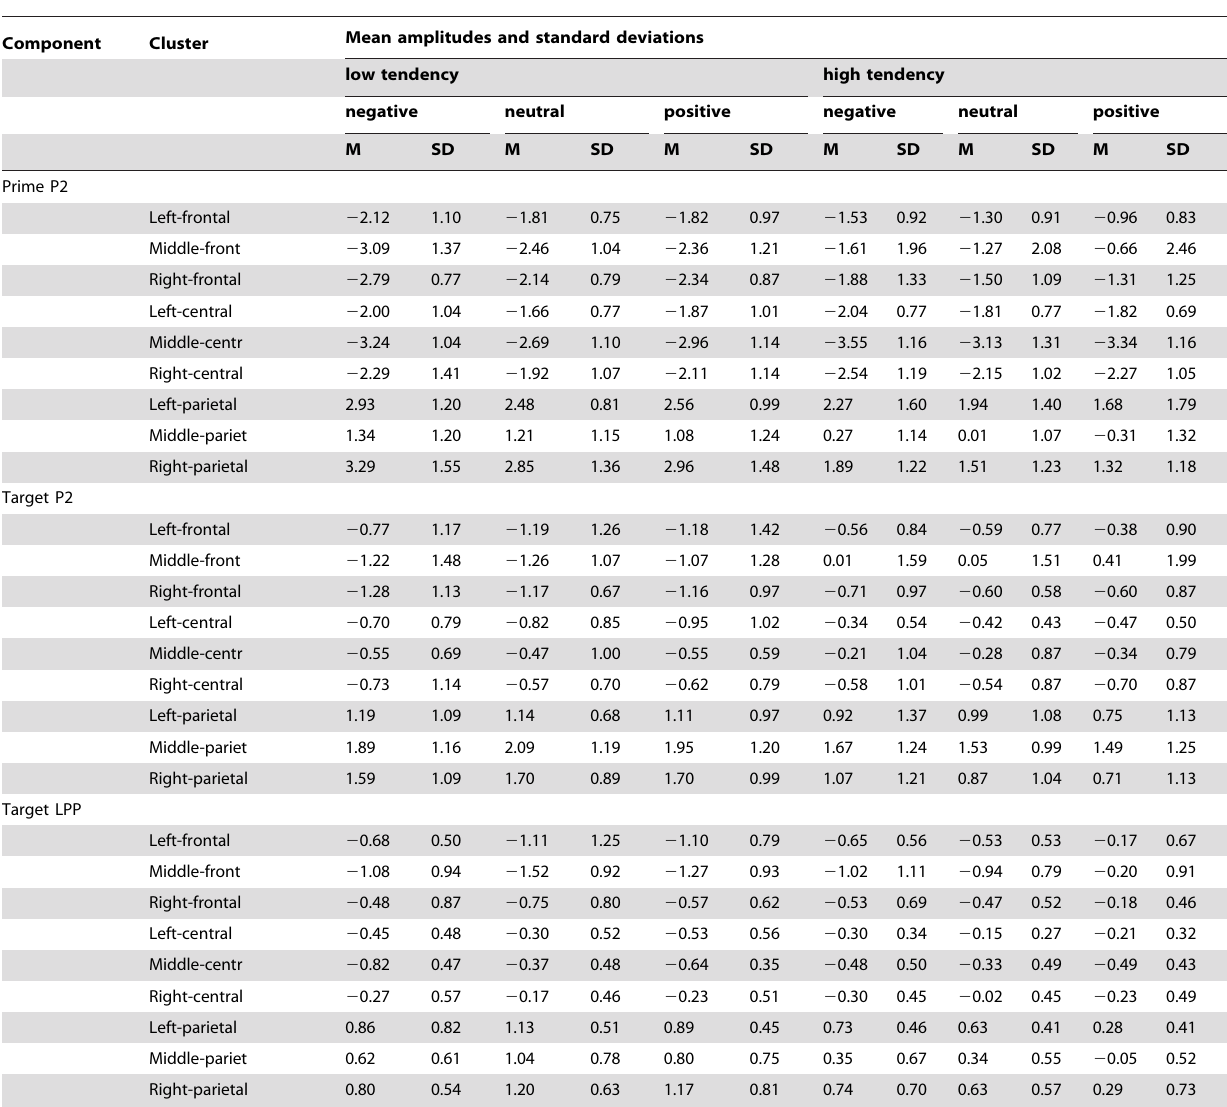
Table 1. Mean amplitudes and standard deviations of ERPs in 9 clusters for negative, neutral, and positive primes in two groups of high and low